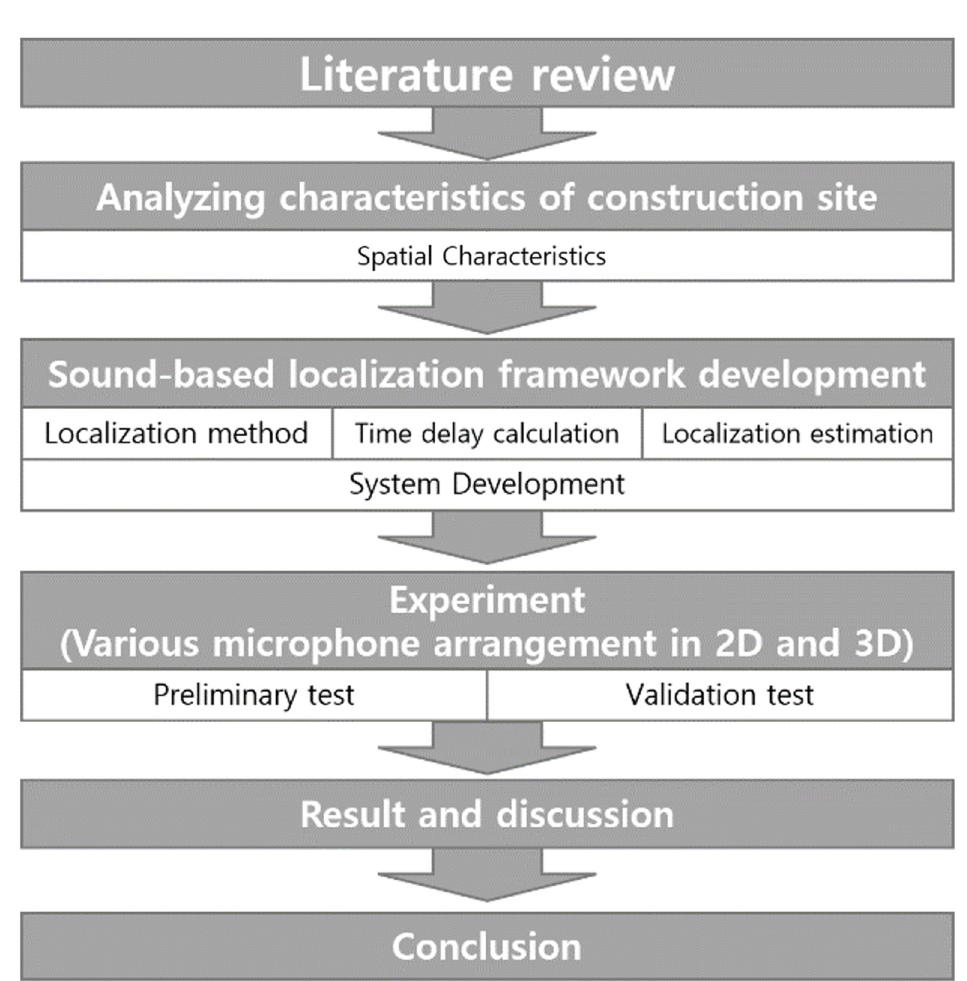
Figure 1. Research process.